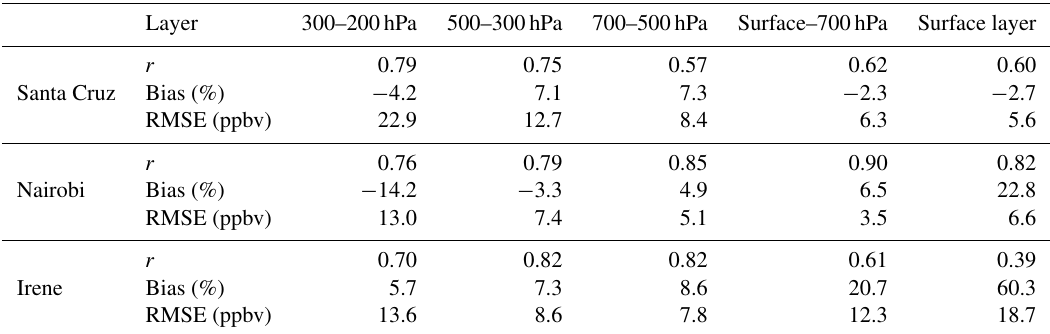
Table 2. The time series of ozone concentrations at different tropospheric layers (see Fig. 3) from the GEOS-Chem simulations and ozonesonde measurements at Santa Cruz, Nairobi, and Irene in Africa. The two datasets are compared in terms of bias (in %), root-mean- square error (RMSE, in ppbv), and correlation coefficient ( r